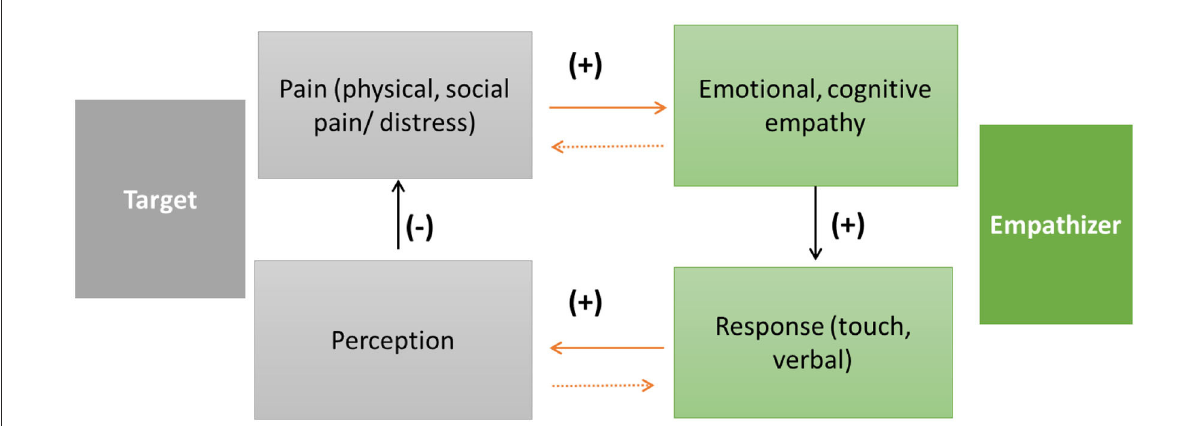
FIGURE1 A model of inter-brain plasticity and empathy: the target is experiencing distress, which triggers empathy (emotional/cognitive) in the empathizer. Emotional and cognitive empathy contribute to reduction of distress by multiple means (e.g., mimicry, synchrony, and verbal responses). Activation in the observation-execution system is coupled between the empathizer and the target. This coupling reduces the target’s distress by activating reward. As empathic interactions continue the empathizer learns how to adapt her reactions based on the target’s feedback. As the empathizer adapts her response to the target, the inter-brain networks between them